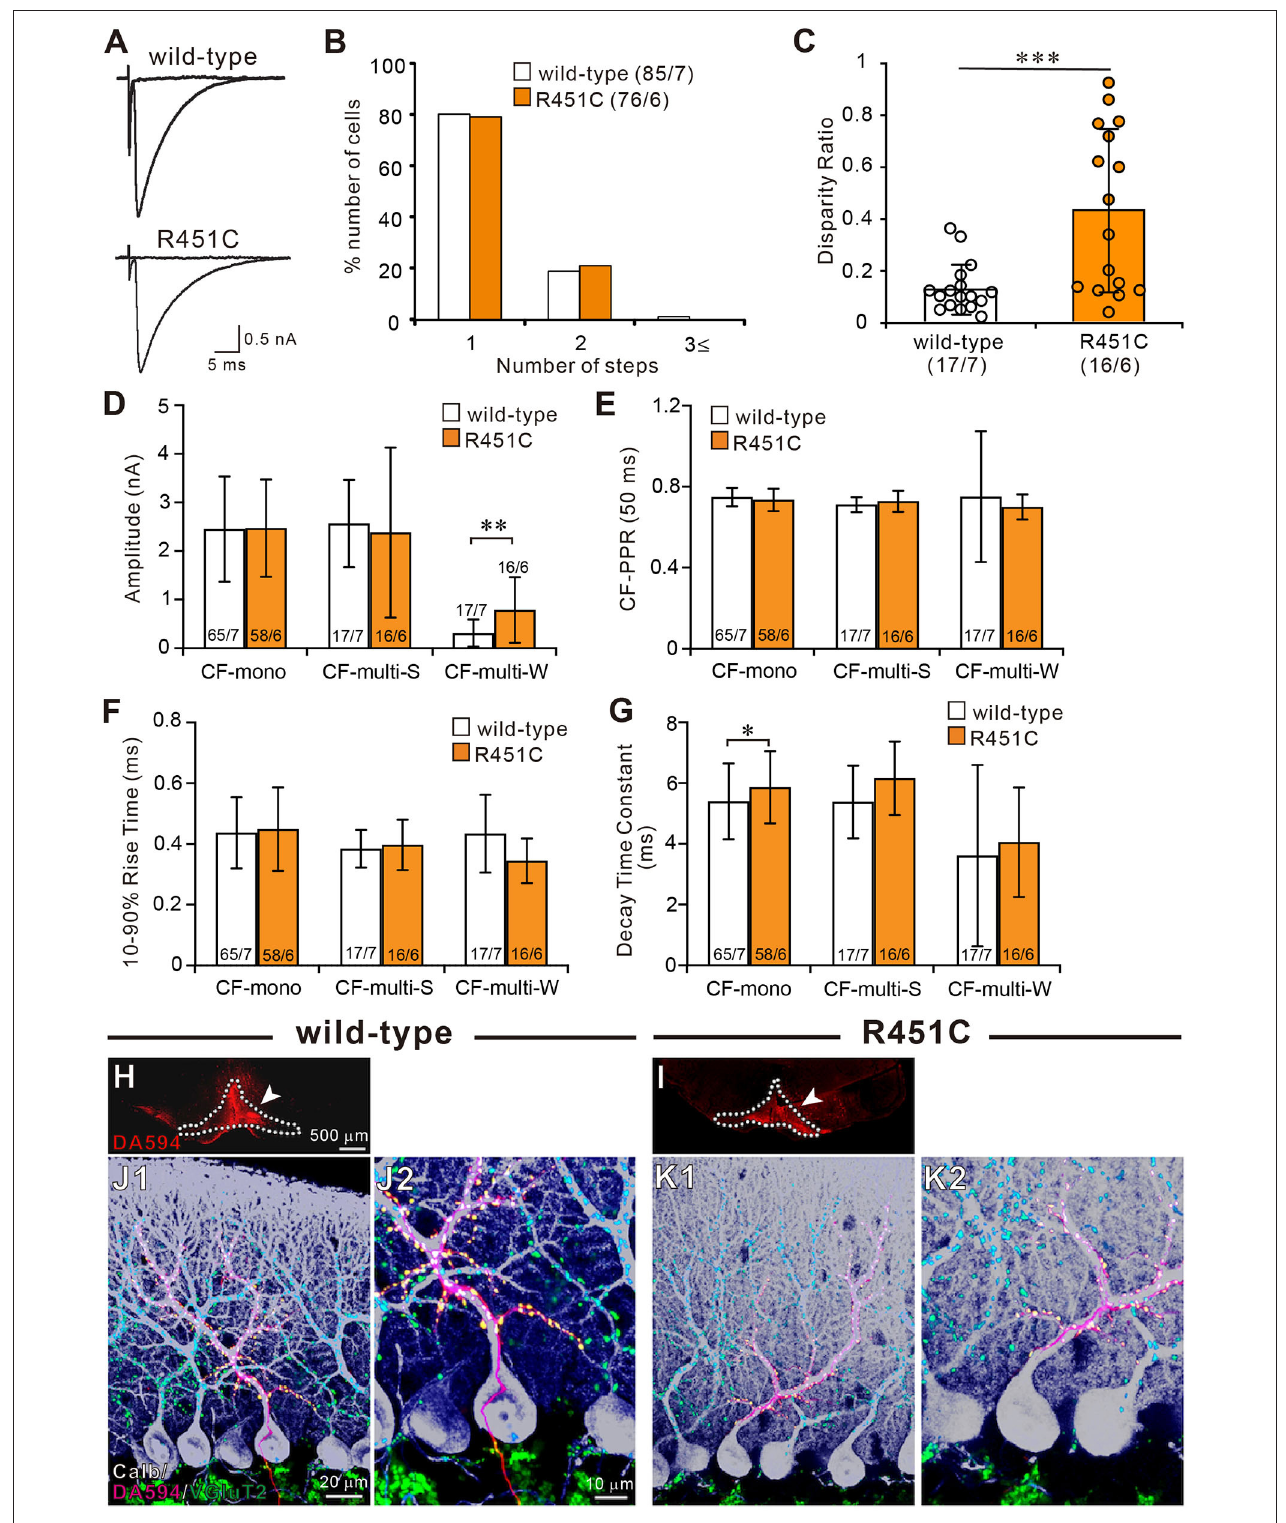
FIGURE 1 | The NLGN3-R451C mutation impairs functional differentiation of multiple CF inputs during synapse elimination. (A) Specimen traces of CF-EPSC recorded from Purkinje cell soma in wild-type and NLGN3-R451C mutant (R451C) mice at P21–P35 at a holding potential (Vh) of − 10mV in the presence of 100 µ M picrotoxin. Scale bars, 5ms and 0.5 nA. (B) Frequency distribution of the number of CF-EPSC steps in each PCs for wild-type (open columns) and NLGN3-R451C